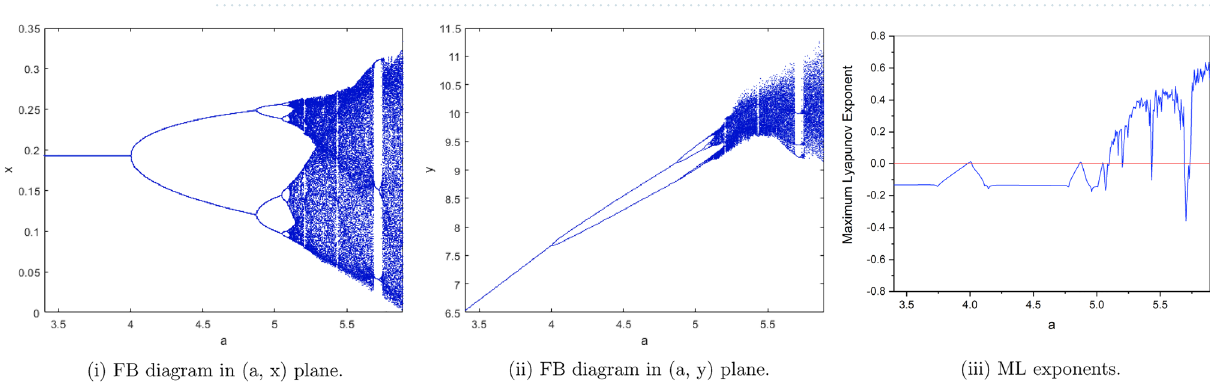
Figure 4. Bifurcation diagrams and ML exponents for the model (i) for values of b = 2, c = 0.1, e = 0.7, h = 0.5926274349, a ϵ [3.4,